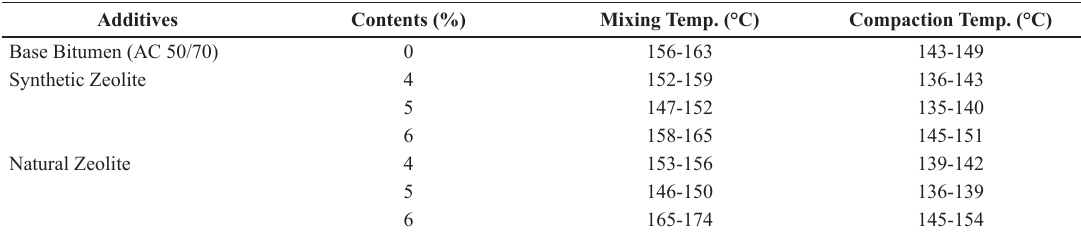
Figure 1. Viscosity vs. temperature Table 5. Mixing and compaction temperatures.